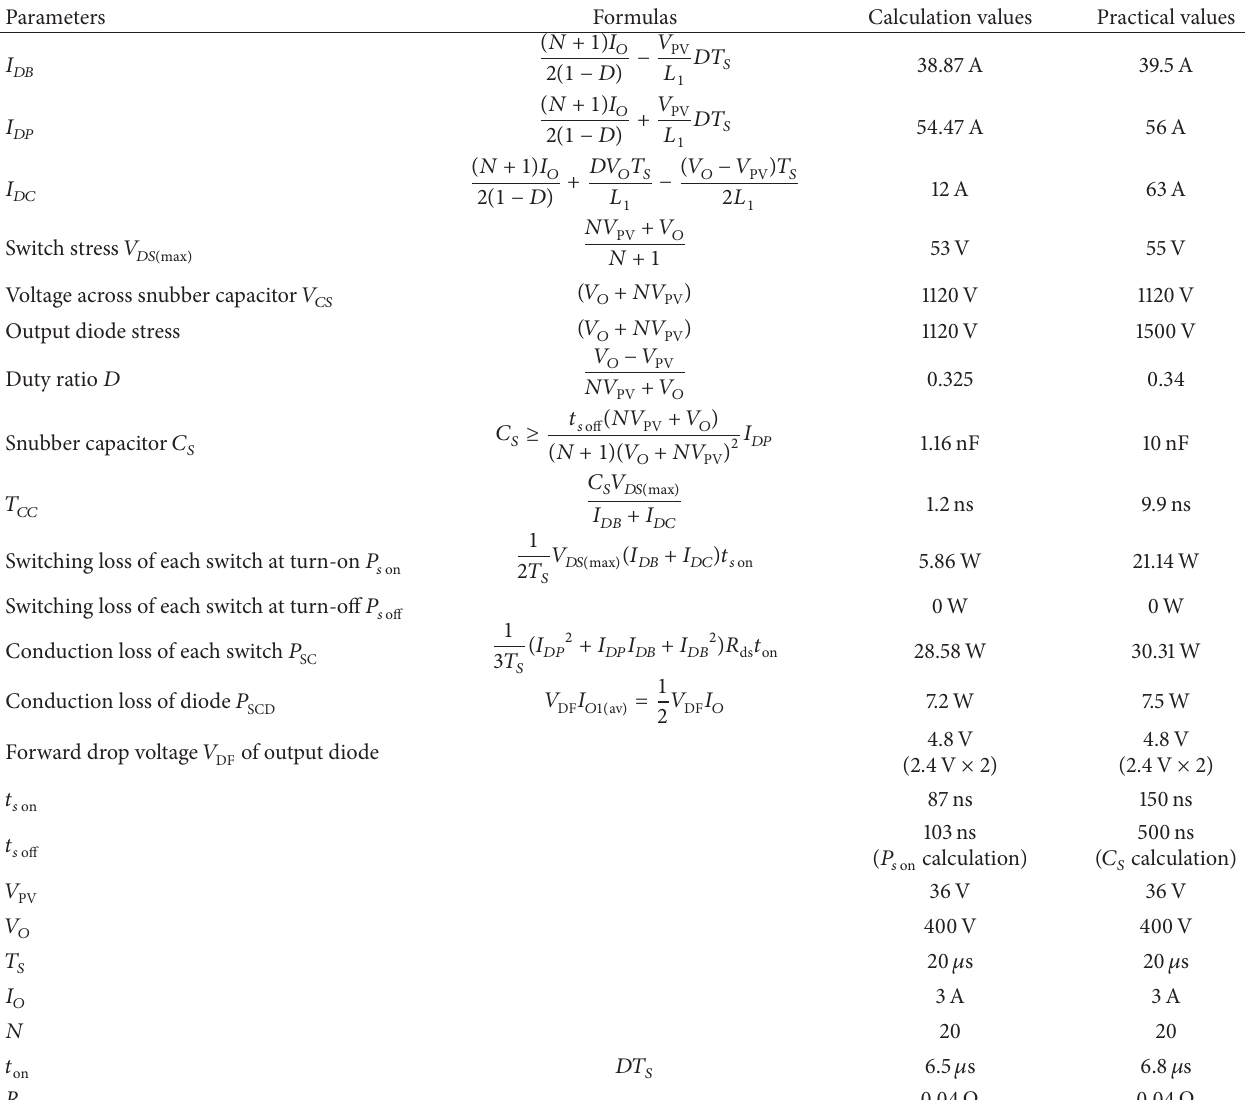
Table 3: Parameter values of the boost converter with single-capacitor snubber under full-load